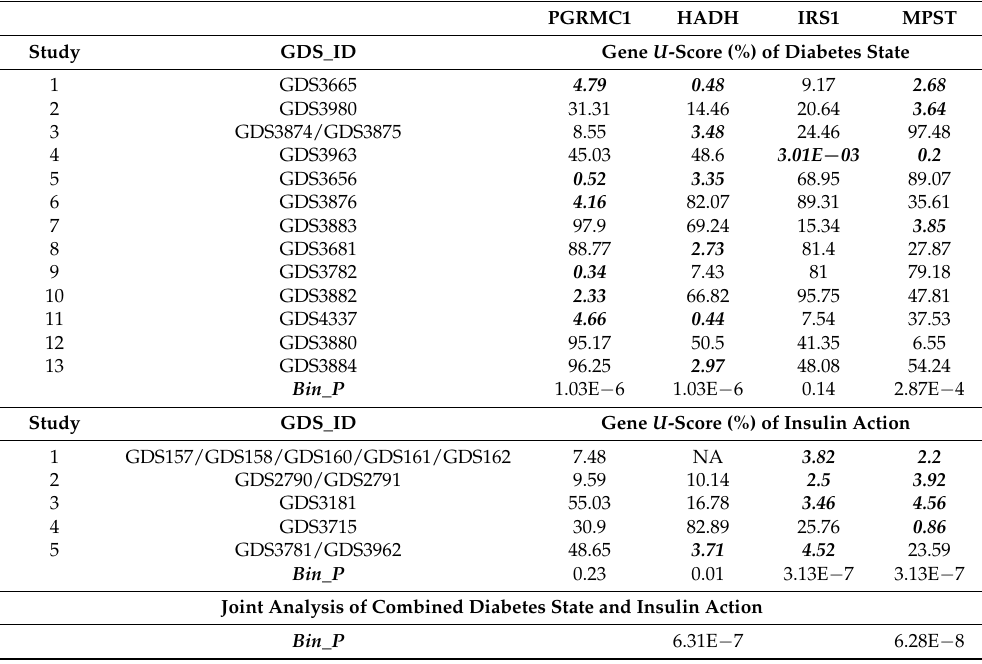
Table 2. Differential gene expression and